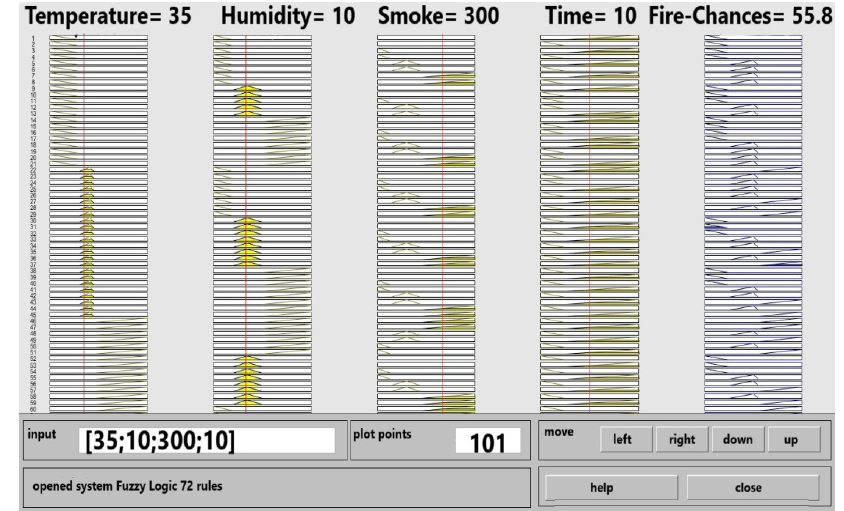
Figure 24. Experiment 3 Fire Chances in MATLAB Rules Viewer.